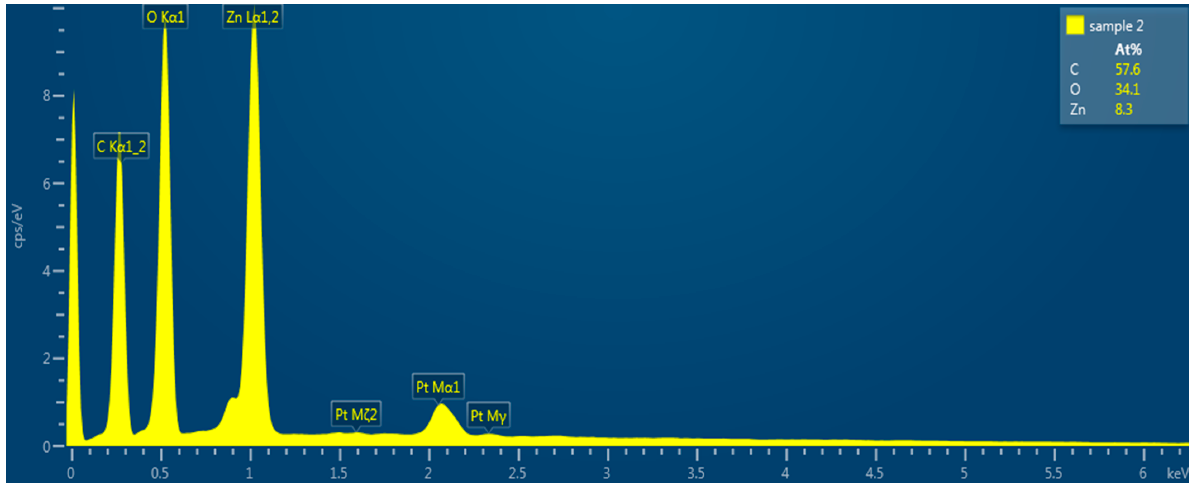
Figure 3. EDS spectrum of zinc-oxide-nanorod-coated cotton fabric.